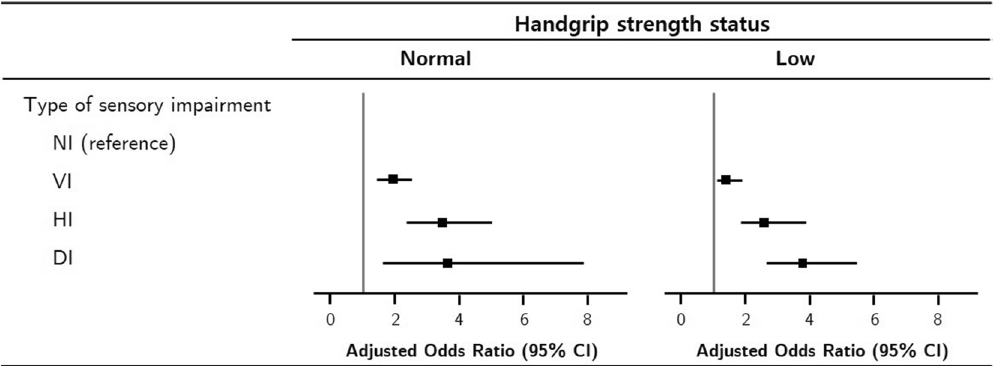
Figure 2. Forest plots of adjusted odds ratios of sensory impairment for the prevalence of cognitive impairment according to handgrip strength status. The adjusted odds ratios were shown as the squares, and the horizontal lines across the square represents for the 95% confidence intervals (CIs). Adjusted for age, gender, education level, marital status, physical activity, smoking, drinking alcohol, body mass index, number of comorbidity